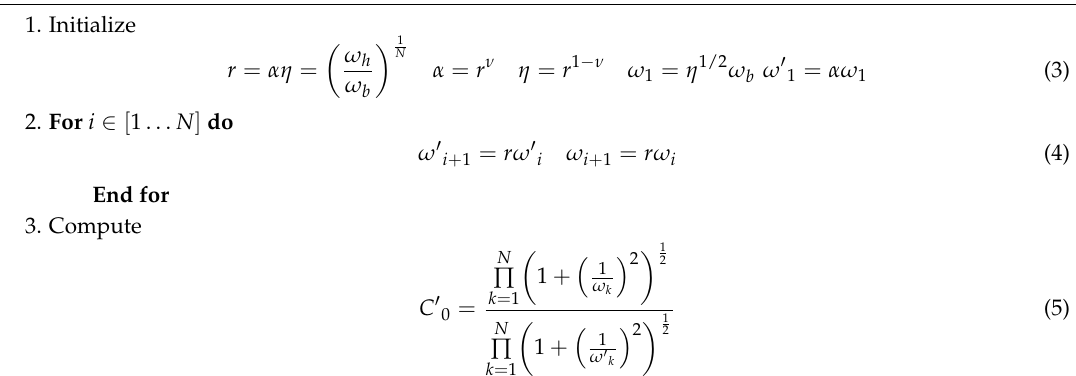
Algorithm 1. Fractional integrator approximation—first method